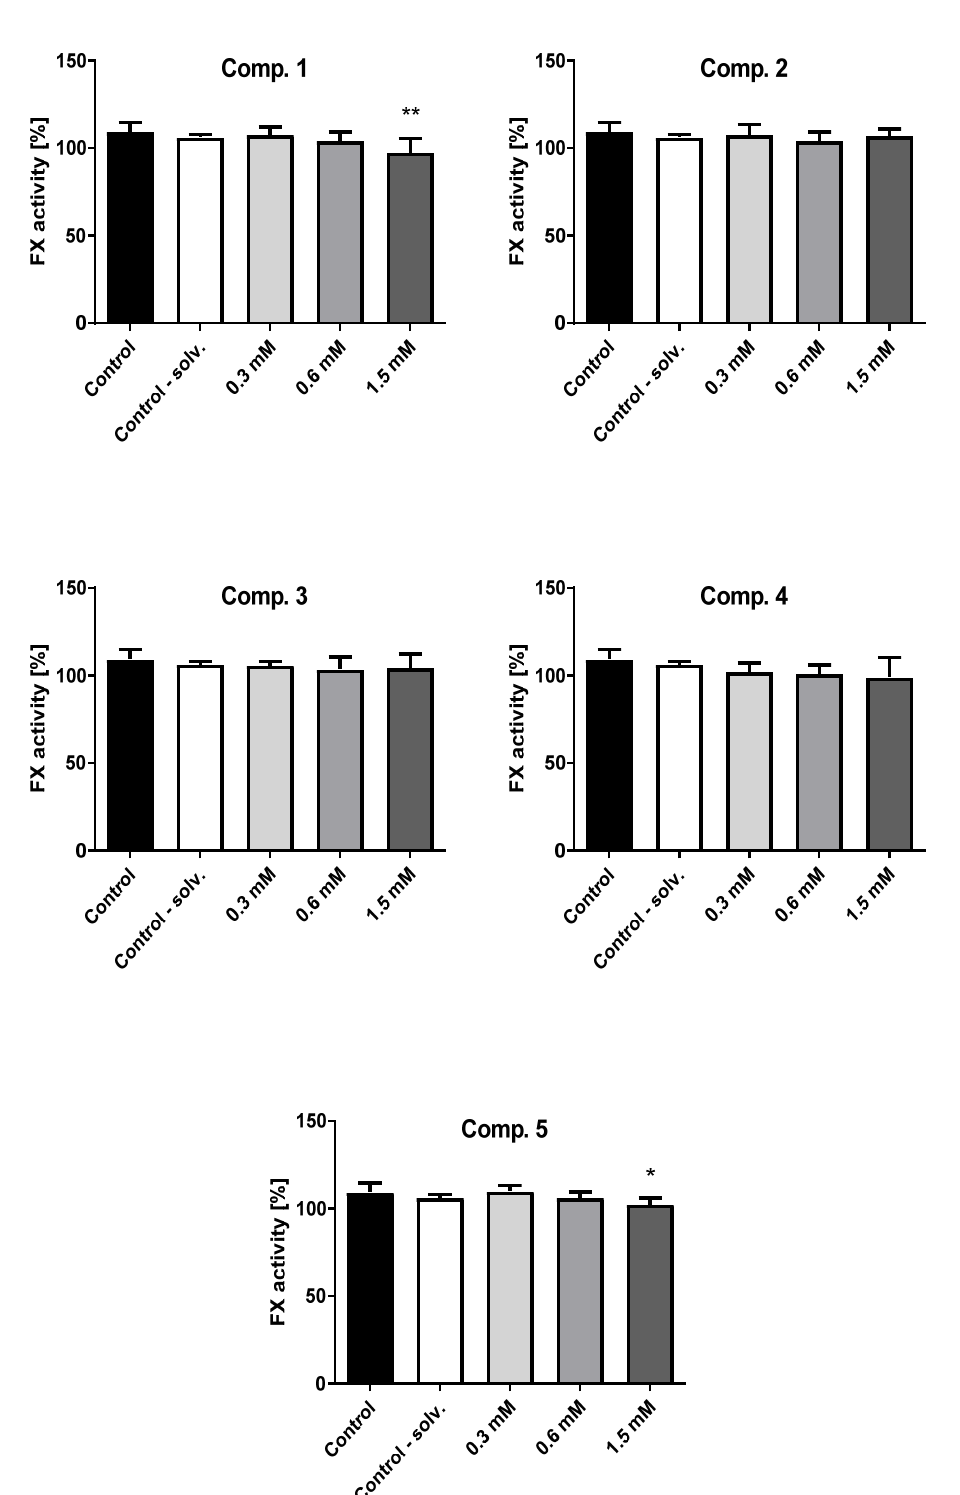
Figure 6. Effects of biguanides 1 – 5 on the activity of factor X (data are presented as mean ± SD; n = 4–5) after 1-min incubation with plasma-deficient factor X. The asterisk denotes a statistically significant difference between the samples treated with compounds and control; * p < 0.05, ** p < 0.01.